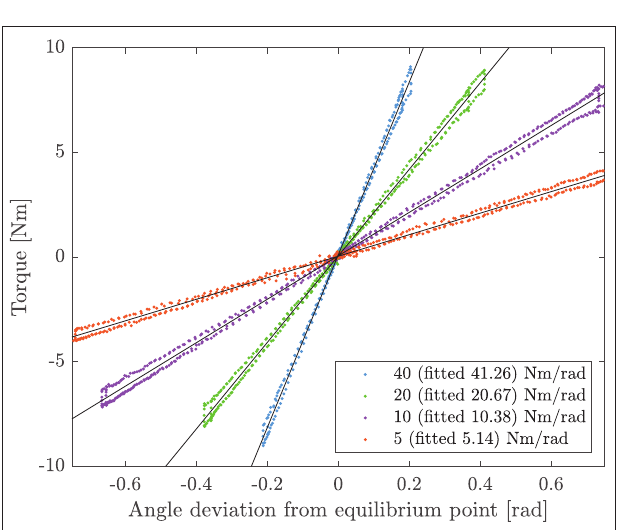
FIGURE 9 | Experimental torsional stiffness. The joint is controlled in impedance at the equilibrium point ( θ = 0 ◦ ). The user exerts external forces to the joint. Torque and angle deviation are measured and compared at different virtual stiffnesses. For the commanded values of 5, 10, 20, and 40 Nm/rad, the measured experimental stiffnesses are 5.14, 10.38, 20.67, and 41.26 Nm/rad,